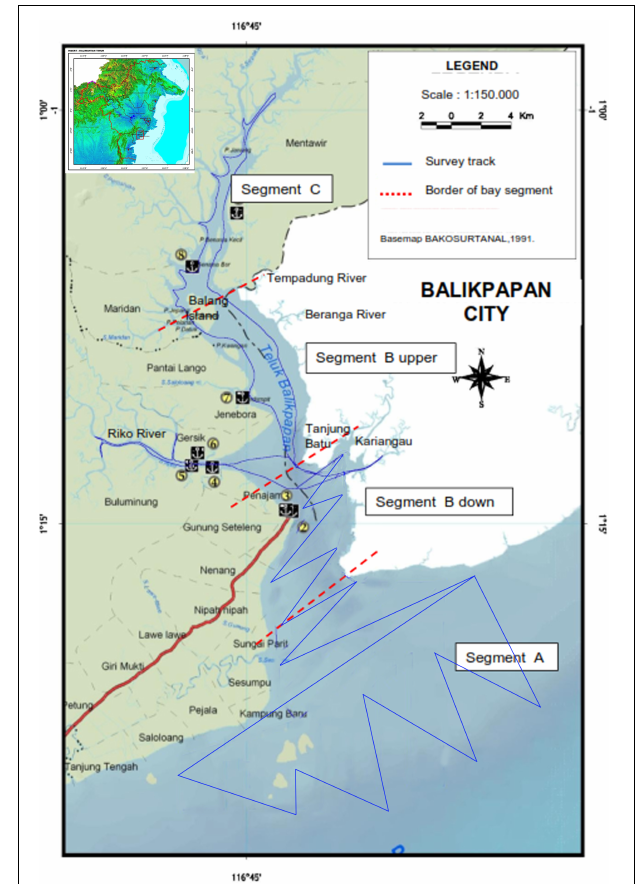
FIGURE 1 | Survey track lines followed during 2000–2001, 2008, and 2015